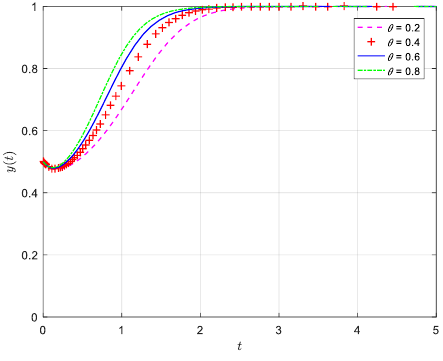
Figure 8. The impact of different system maintenance cost coefficients  on the enterprise, service provider, and government.